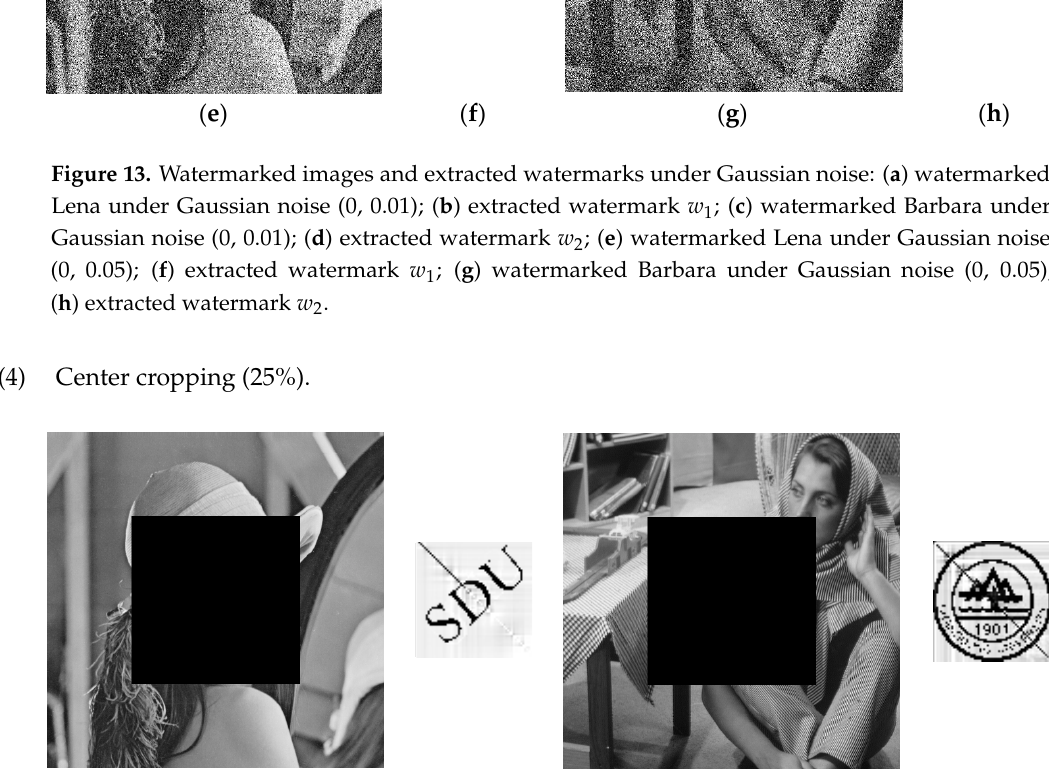
Figure 14. Watermarked images and extracted watermarks under center cropping (25%): ( a ) watermarked Lena; ( b ) extracted watermark w 1 ; ( c ) watermarked Barbara; ( d ) extracted watermark w 2